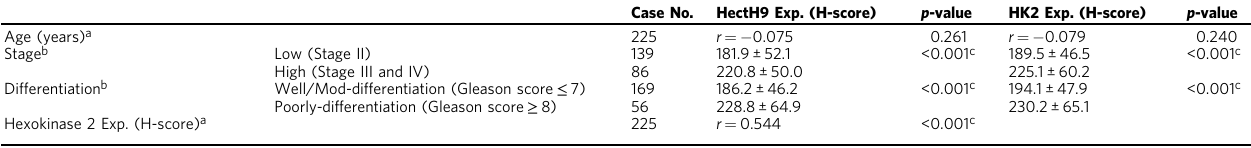
Table 1 Correlations between HectH9 and HK2 expression and clinicopathological parameters in prostate carcinoma Case No. HectH9 Exp.